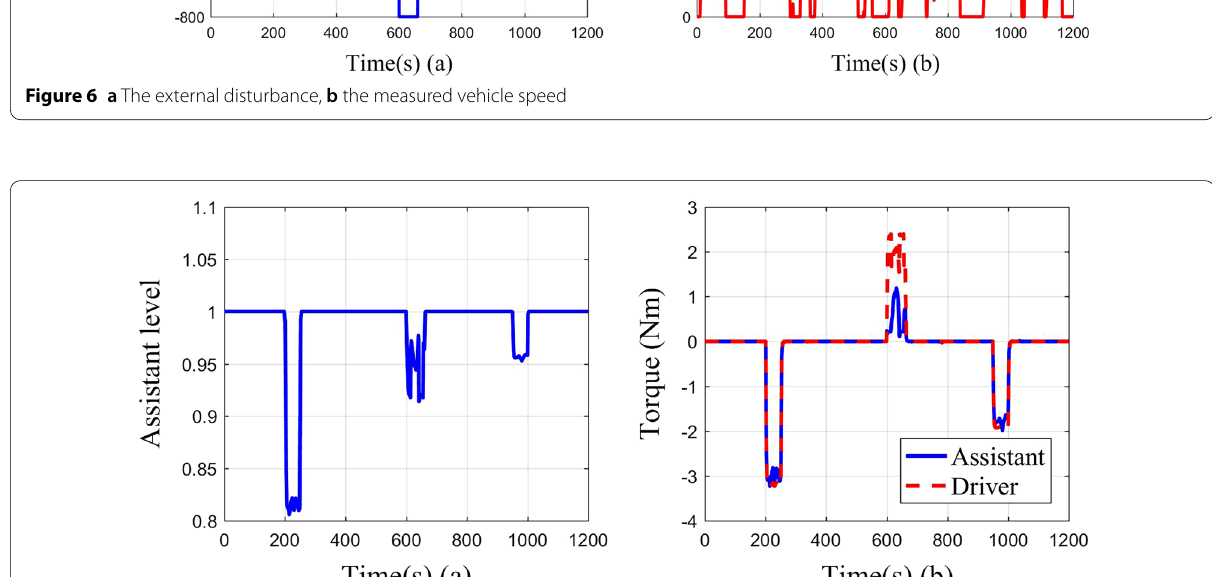
Figure 7 a Assistance level according to driver’s activity, b the driver torque and the assistance